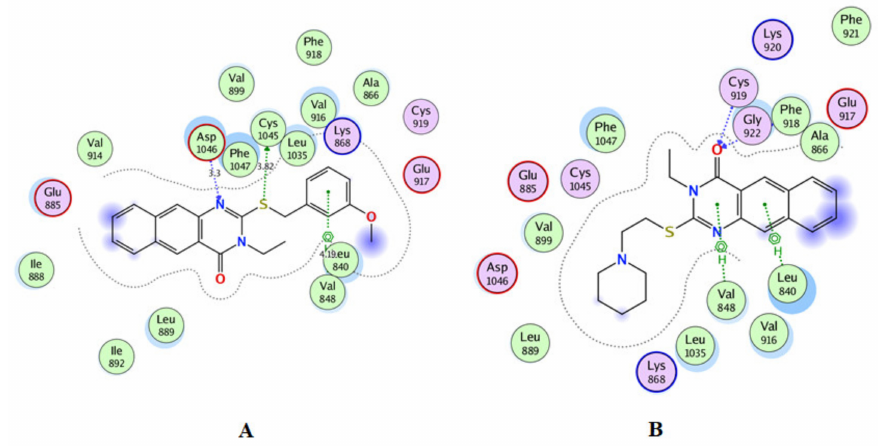
Figure 9. 2D interactions in the active site of VEGFR2 for compound 13 ( A ) and for compound 14 ( B